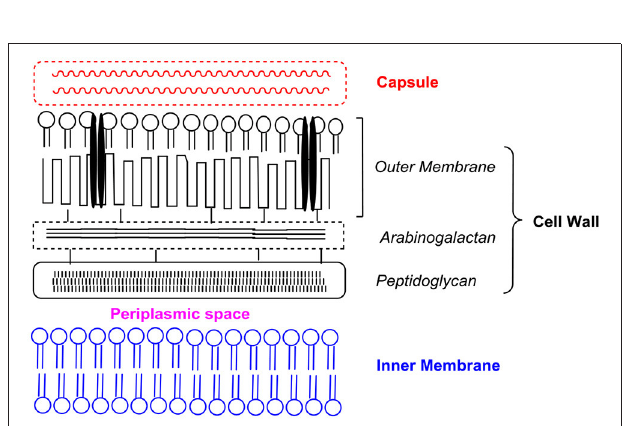
FIGURE 2 | Schematic representation of the different components of the mycobacterial cell envelope based on the description given by Daffé et al. (2017) . Presentation is not drawn to scale. Interspersed within the outer membrane are porin channels (depicted as black parallel bars) for the uptake of small hydrophilic